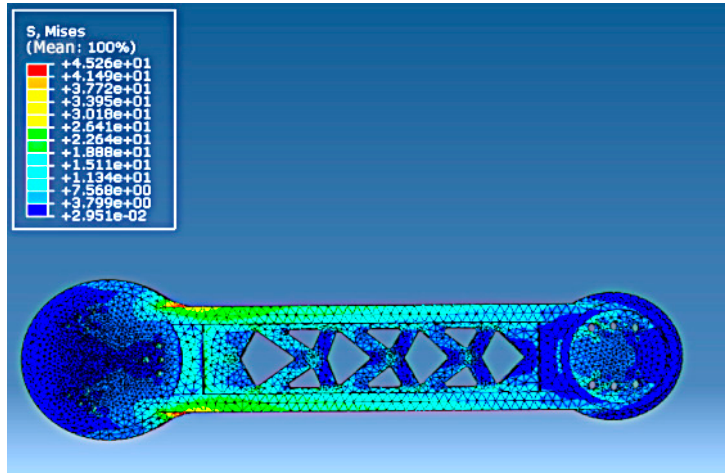
Figure 23. Mises stress distribution in the most unfavorable working condition.